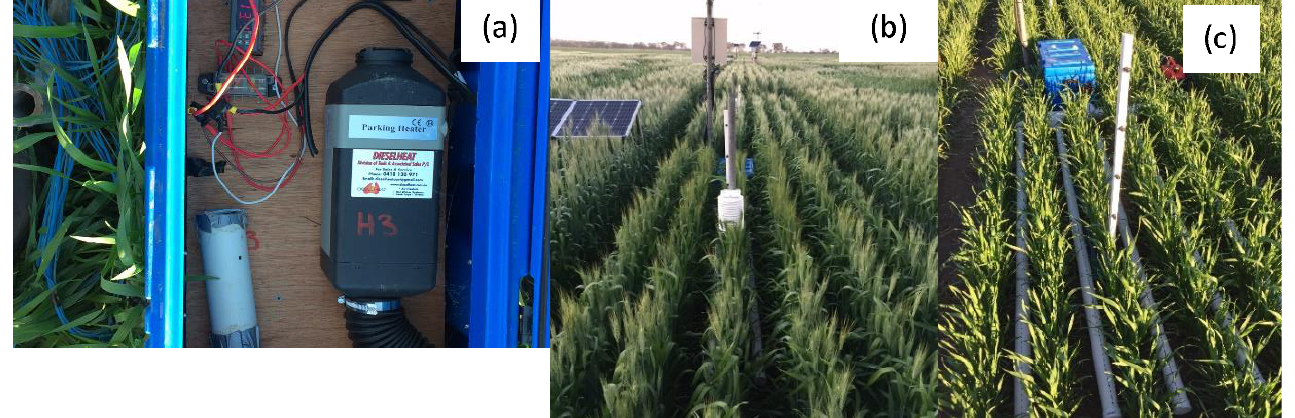
Figure 2. A 2 kW diesel plot heater (Belief, Diesel Heat, TAS Australia) housed in a waterproof case ( a ); the weather station (dataTaker DT50-S3, Lontek, NSW, Glenbrook, Australia) which recorded humidity (Vaisala Humitter 110 with a Humicap sensor, Lontek, NSW, Glenbrook, Australia) and canopy air temperature (T-type, Temperature Controls Pty. Ltd., Sydney, NSW, Australia) in non- heated and heated plots and activated the heater ( b ); the unshielded thermocouples which measured canopy air temperature and the heated plot area of wheat ( cv . Wyalkatchem) ( c ). A FLIR T420 (Teledyne FLIR, Wilsonville, OR, USA) was used to take thermal images